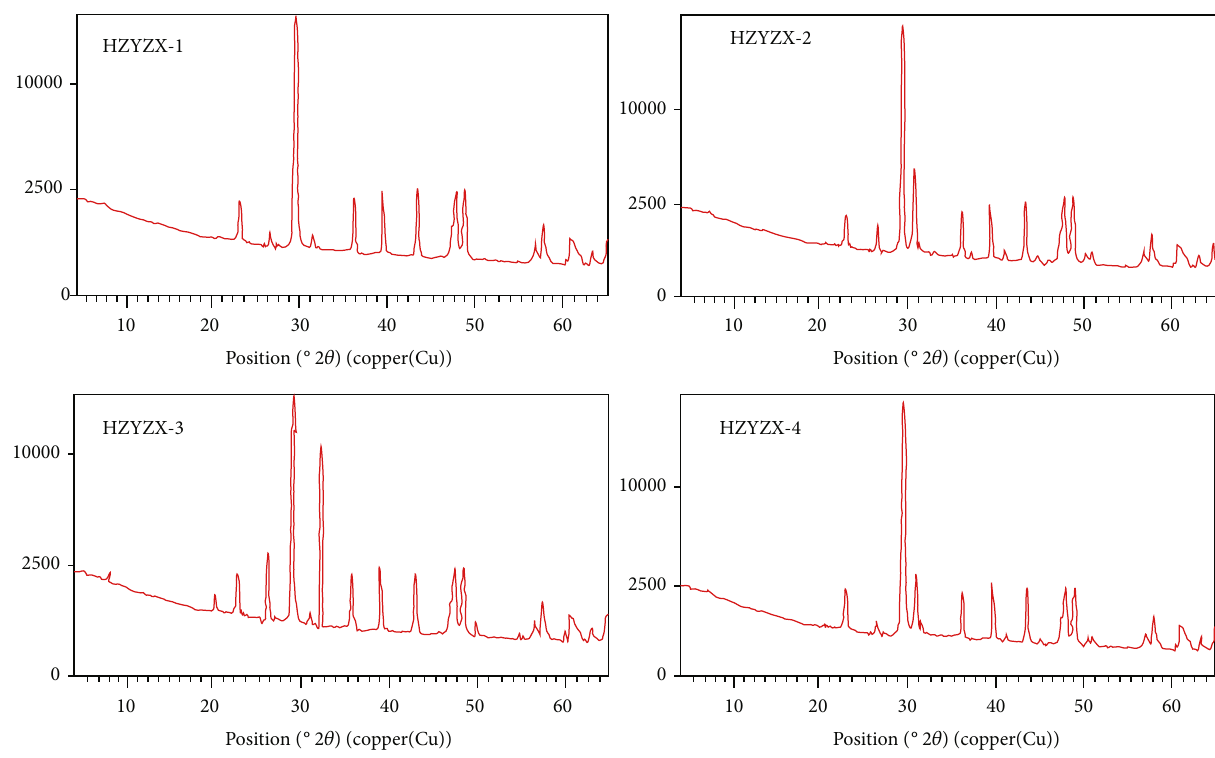
Figure 4: XRD spectrum of carbonate samples from dendrolites. Table 2: Carbon and oxygen isotopic data for carbonate rocks from dendrolites in the Houziyu